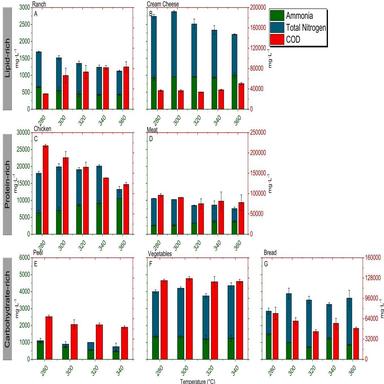
Distribution of total nitrogen, ammoniacal nitrogen, and chemical oxygen demand across range of HTL reaction temperatures for the different feedstocks. Lipid-rich, Protein-rich, and Carbohydrate rich feedstocks are arranged in the top, middle, and bottom rows, respectively (Total Nitrogen = Blue and Ammoniacal Nitrogen = Green, both corresponding to the left y-axis, while COD = Red, corresponding to the right y-axis).